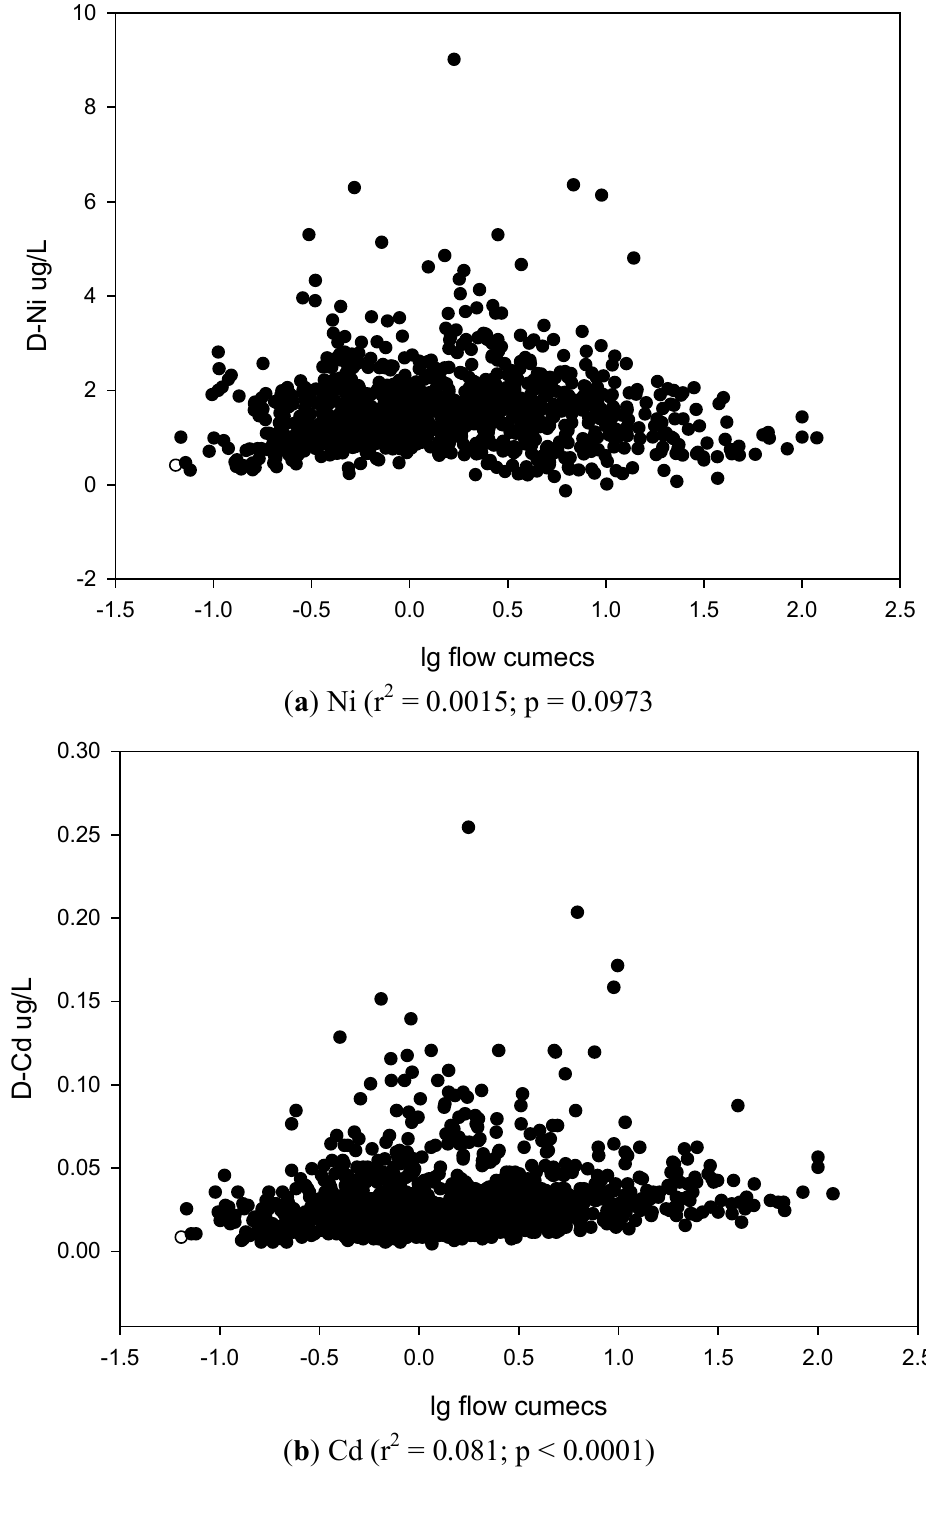
Figure 3. The relationships of concentration with flow for the dissolved metals ( a ) Ni, ( b ) Cd, and ( c )